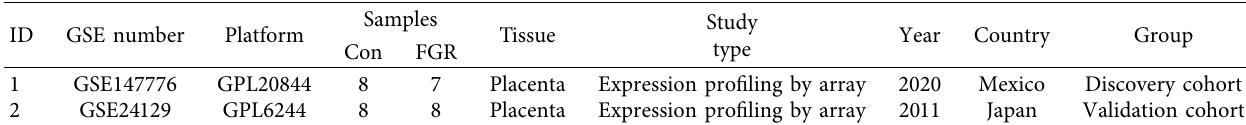
Figure 1: Te fowchart of this Table 1: Information of GSE147776 and GSE24129 in GEO.